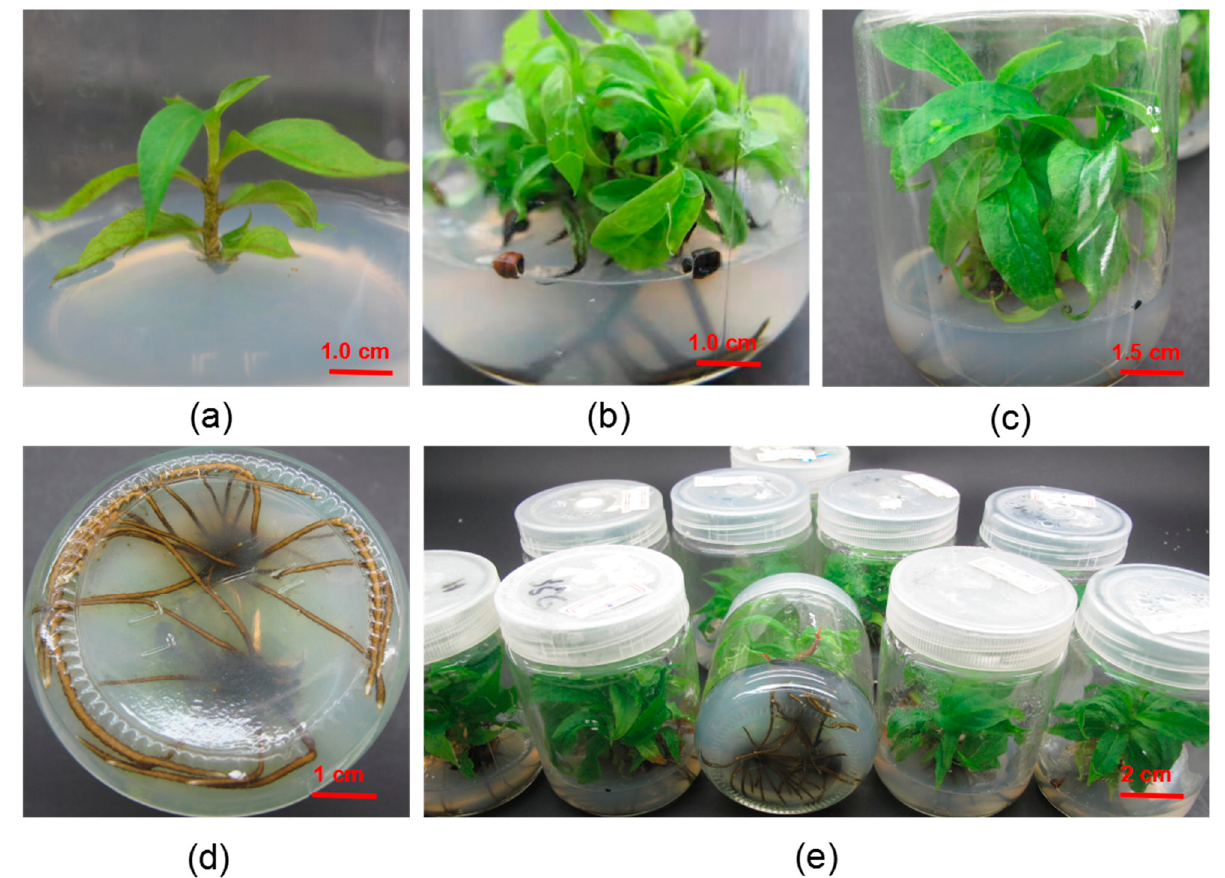
Figure 7. Rooting Culture of D. lotus ( a ) The stem segments of single adventitious shoots were lignified after 10 days of culture. ( b ) Adventitious roots appeared after 25 days of rooting culture. ( c ) The growth of the upper part of root after 40 days of rooting culture. ( d ) Root growth after 40 days of rooting culture. ( e ) Overall photo of rooting culture.